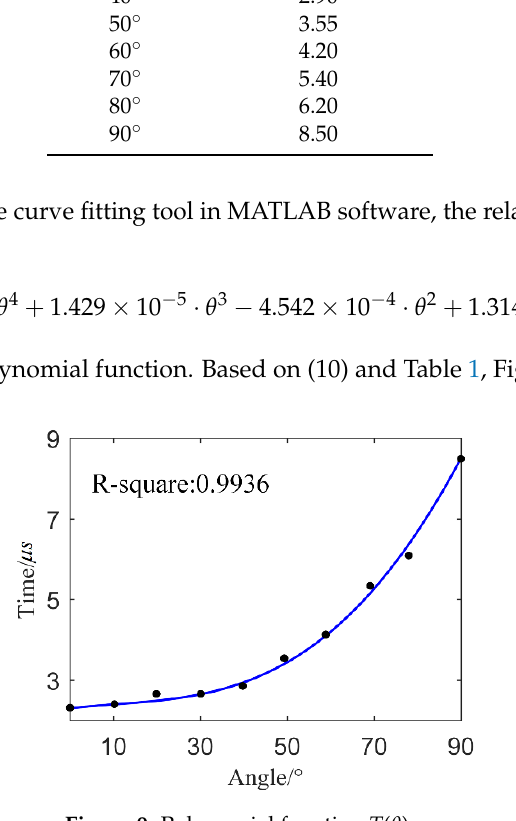
Figure 9. Polynomial function T ( θ ).